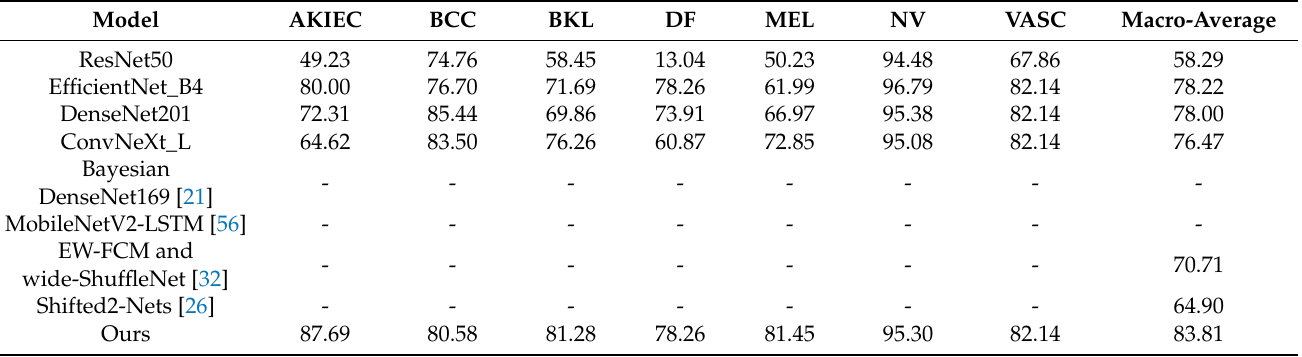
Table 11. The recall of each model on the public dataset HAM10000 (test set of 2000 images); the missing values of indicators are replaced by “-”, and the unit is